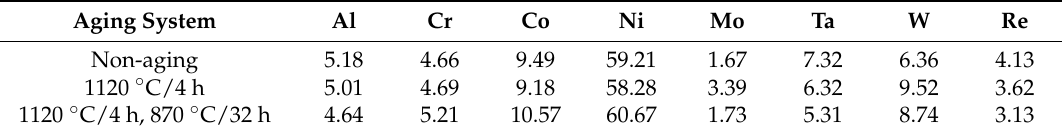
Table 7. Composition (mass fraction) of the matrix phase under three aging